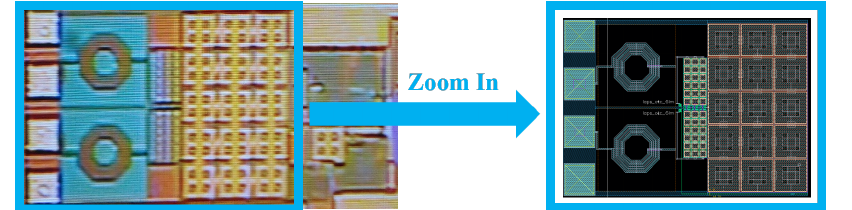
Figure 20. Location of the HF section inside the microphotography of the whole self-powered tag and a zoomed-in view of its layout.